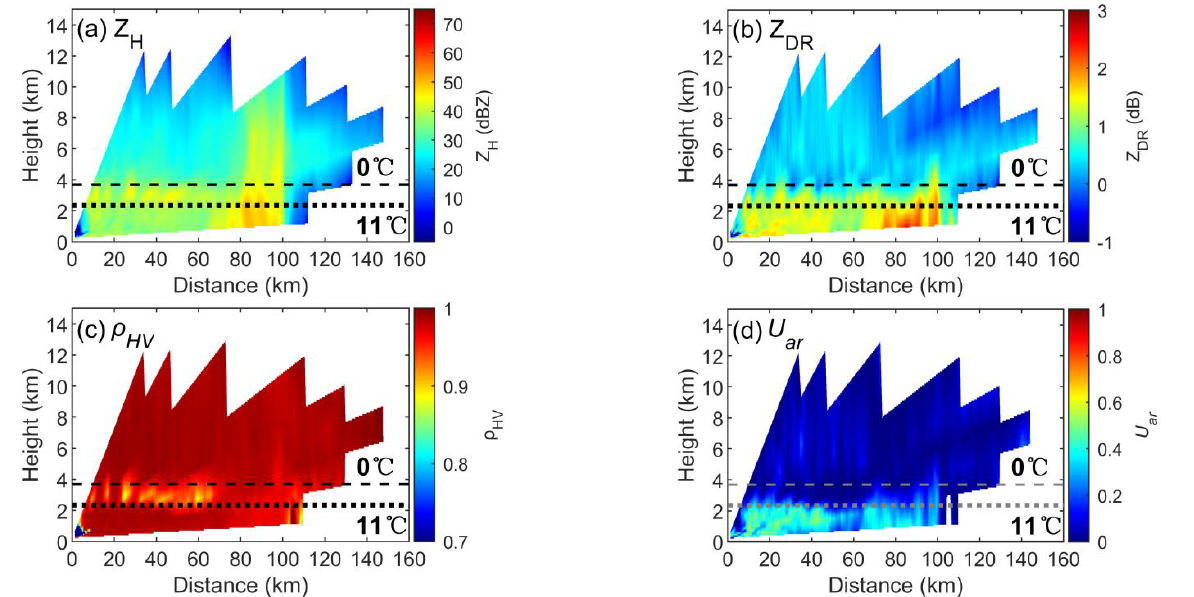
Figure 16. Composite RHI at 130° azimuth from the S-band dual polarization weather radar. (The data time is 17 May 2020 23:51 LST, the same as Figure 15. The radial data are smoothed by 10-point median filtering, and triple linear interpolation is used to derive this composite result). ( a ) Z H , ( b ) Z DR , ( c ) ρ hv , ( d ) U ar .